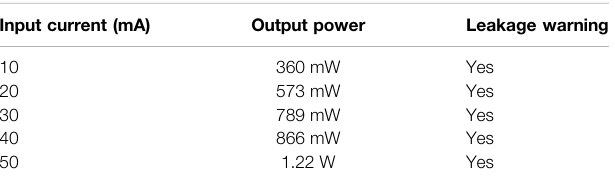
TABLE 2 | Experimental results of the energy extraction circuit based on LTC3588. Input current